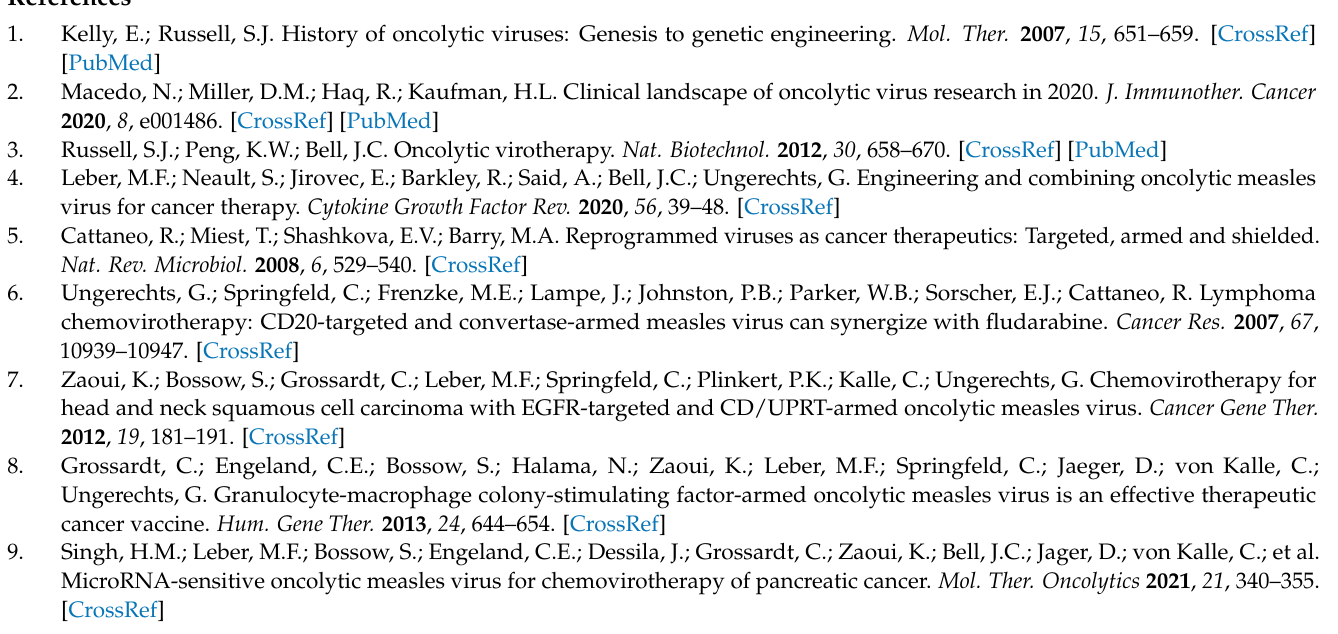
Figure S4: Localization of Drosha in PC9 and HEK-293 cells upon poly(I:C) treatment or MeV-infection. HEK-293 and PC9 cells were mock-treated, treated with 10 µ g/mL poly(I:C) or infected with MeV ld-EGFP (MOI = 0.3; green). Drosha (red) and the nucleus (blue) were stained with antibody and DAPI, respectively. The scale bar corresponds to 20 µ m. Figure S5: PC9, HEK293 and Vero cells were either infected with MeV ld-MeVami-122 H-EGFP (MeVami-122) at MOI 0.3 or transfected with 1 µ g pCG MeVami-122 and harvested 25–30 h p.i., when cells were completely in syncytia. Mature and primary miRNA was isolated and analyzed via qPCR in technical triplicates. Relative expression to pCG-derived miRNA is shown. Mean values of n = 2 experiments are plotted. Error bars indicate standard